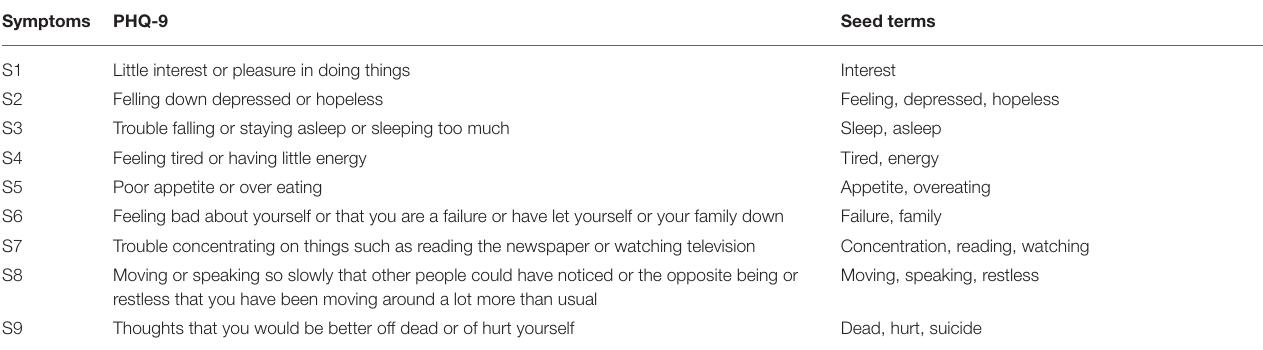
TABLE 1 | PHQ-9 questionnaire and seed terms for each symptoms. Symptoms